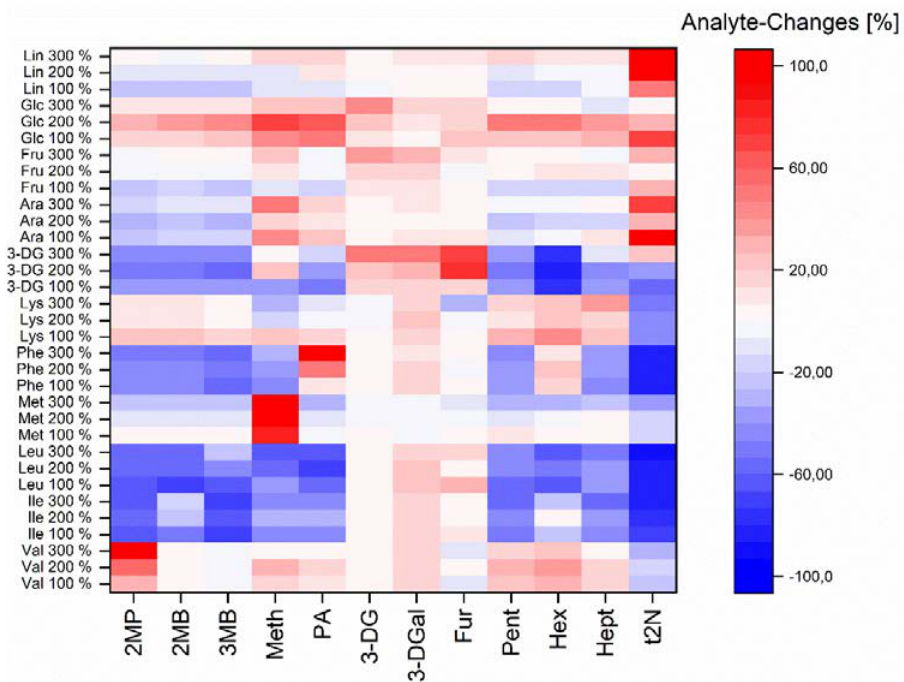
Figure 5. Relative changes [%] in dicarbonyl and aldehyde concentrations by artificially spiked various precursor substances after model wort boiling. various precursor substances after model wort